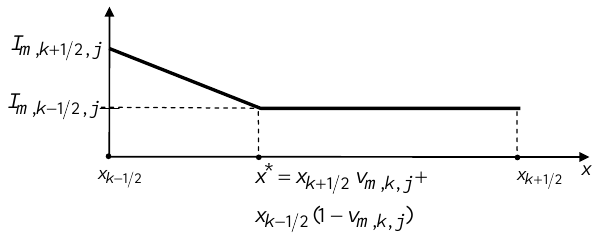
Fig. 6. The piece-linear approximation to the RTE solution over the spatial variable x under ξ m > 0.